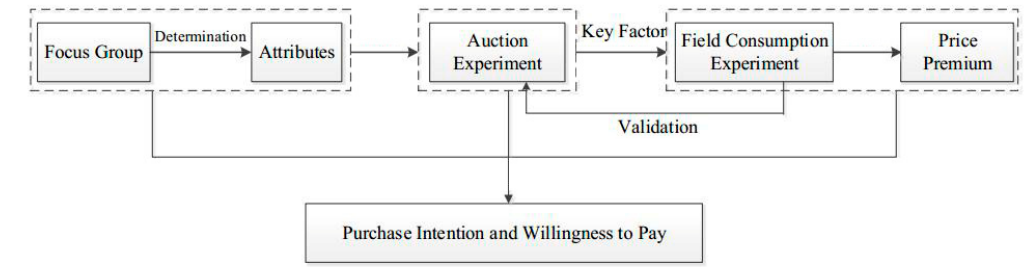
Figure 1. Experiment design of this study.